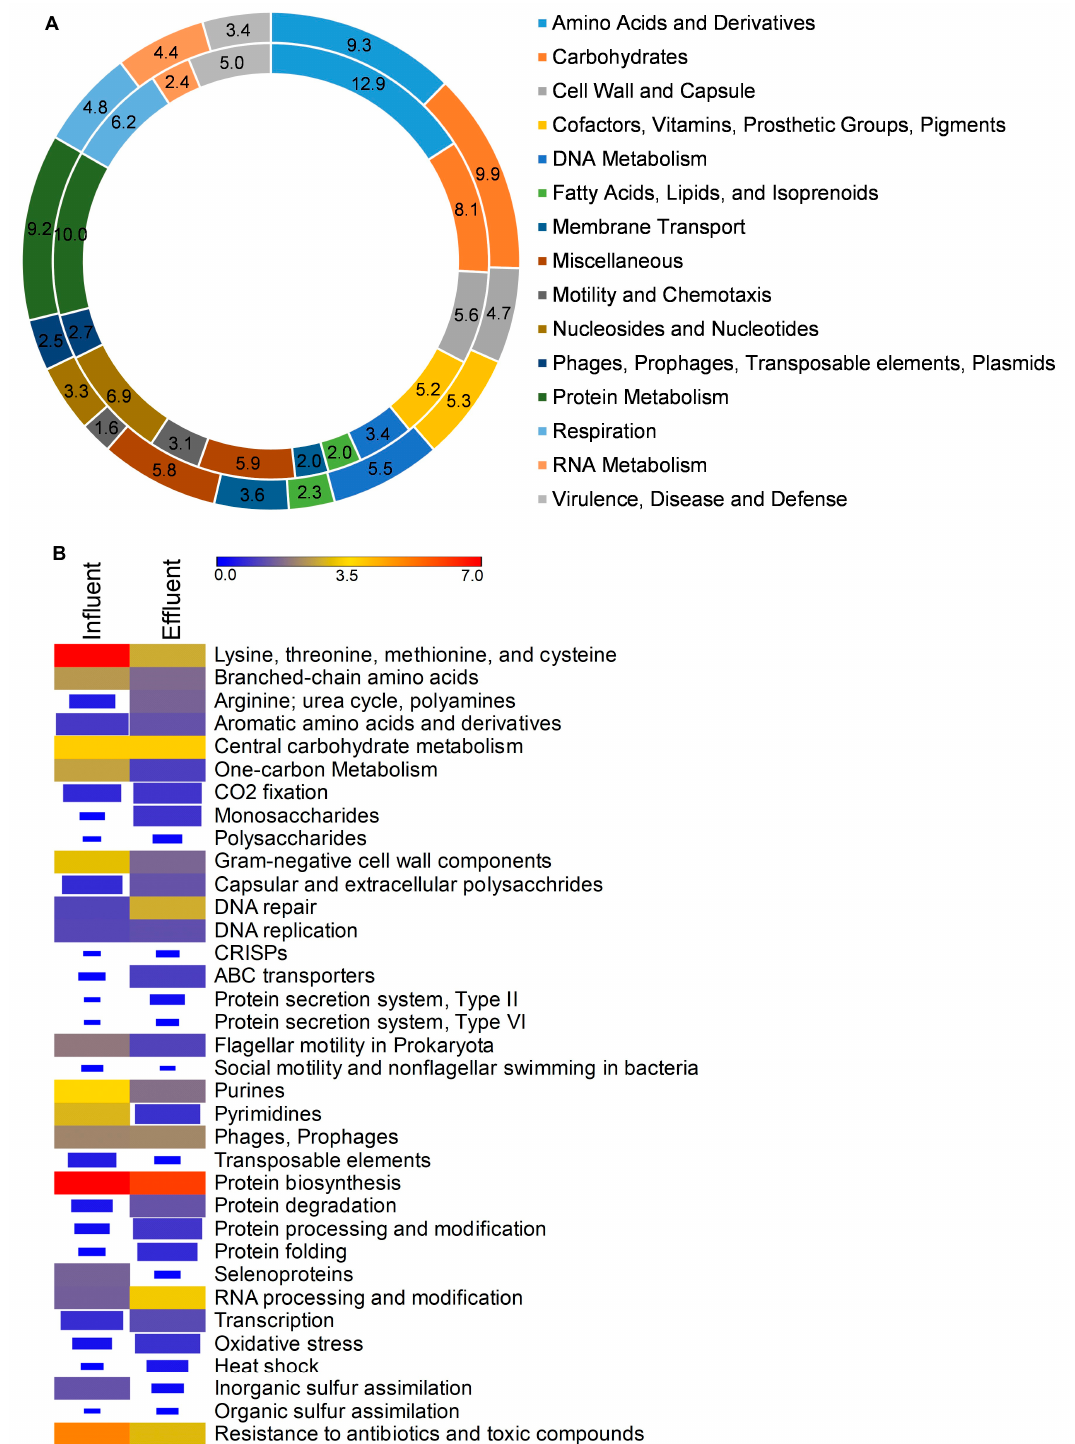
Figure 5. Functional analysis of the influent and effluent metagenomes. Percentage relative abundance of the dominant pathways identified by seed-subsystem mapping using MGRAST. ( A ) Abundance of the dominant pathways at level 1. Outer circle effluent and inner circle influent. ( B ) Abundance of the dominant pathways identified at sub-level 2. The size and color shade of the rectangle boxes are proportional to the relative abundance of the